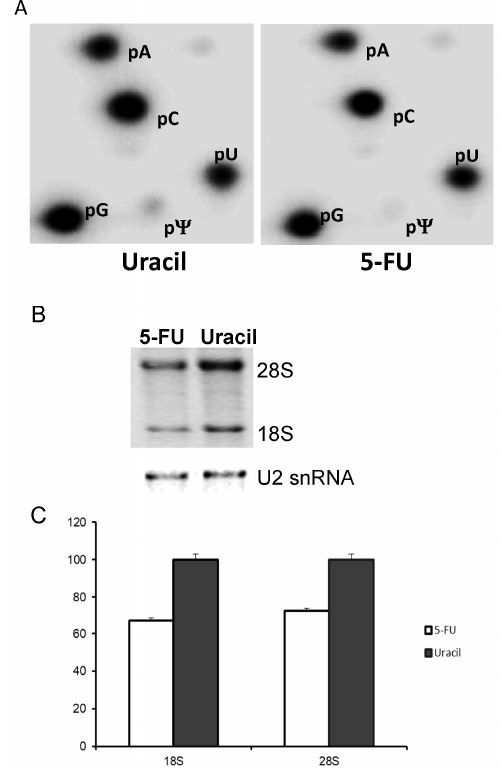
Figure 3. Ribosomal RNA (rRNA) pseudouridine levels as well as rRNA levels in SW-480 cells treated with uracil or 5-FU. ( A ) 18S and 28S rRNA were gel-purified from [ 32 P]-orthophosphate pulsed SW-480 cells cultured in medium containing uracil (left panel) or 5-FU (right panel), and subjected to nuclease P1 digestion and 2-dimensional thin layer chromatography (2D-TLC). Spots corresponding to adenosine (pA), cytosine (pC), guanosine (pG), uridine (pU), and pseudouridine (p Ψ ) are labeled. For uracil-treated cells (left panel), the pU/p Ψ ratio is ~5%; for 5-FU-treated cell (right), the pU/p Ψ ratio is ~1%. ( B ) Total RNA from 5-FU- and uracil-treated cells was resolved by electrophoresis, and photographed (top). As a loading control, U2 small nuclear RNA (snRNA) was detected by Northern blotting (bottom). ( C ) Relative levels of 18S and 28S from 5-FU- and uracil-treated cells were